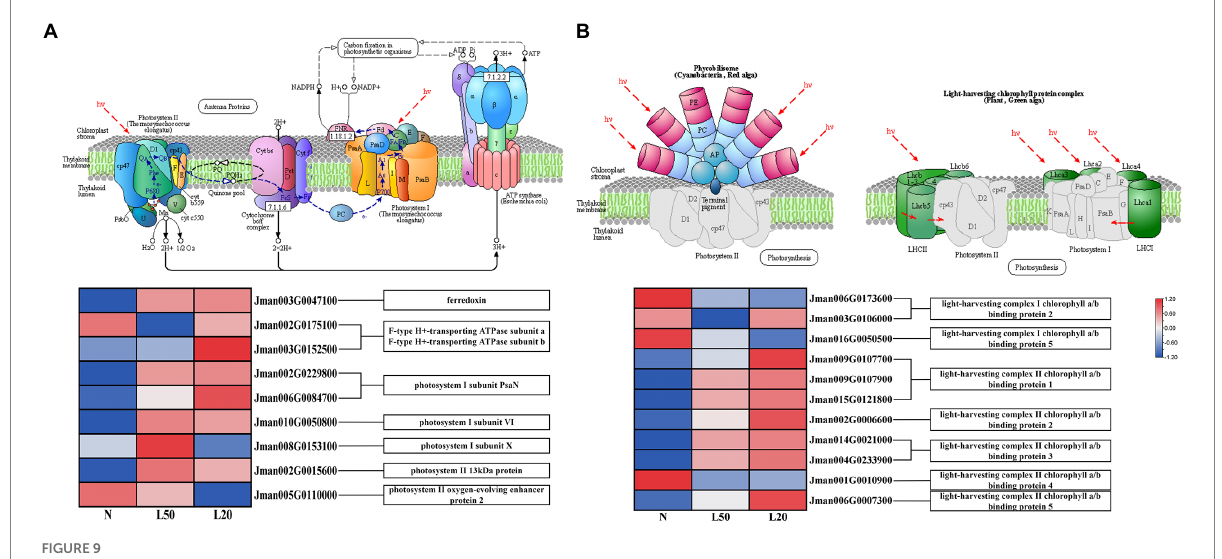
FIGURE 9 Expression of DEGs involved in response to photosynthesis. (A) The structure and mechanism of photosynthesis and a heatmap of the expression levels of DEGs involved in photosynthesis. (B) The structure of photosynthesis-antenna proteins and a heatmap of the expression levels of DEGs that were found to be involved in response to light stimuli. N: natural sunlight. L50: 50% sunlight to go through. L20: 20% sunlight to go through. The color scale from Min (blue) to Max (red) refers to the expression value from low to